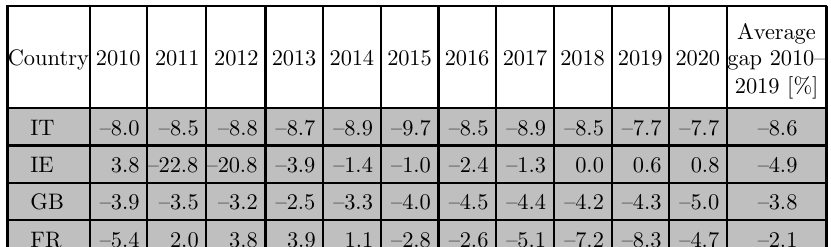
The cash and deposit gap of public sector – liquidity risk in relation to GDP in 2010–2020